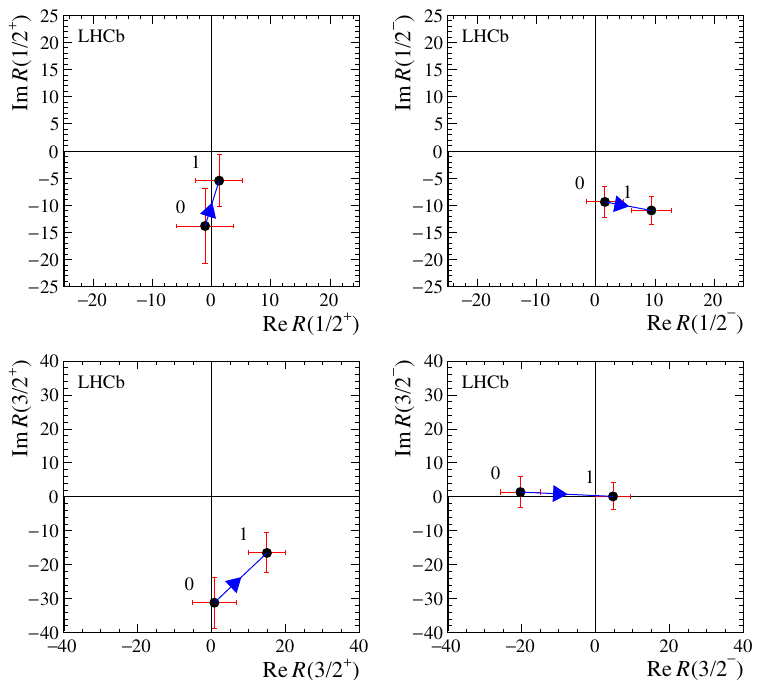
Figure 8 . Argand diagrams for the four amplitude components underneath the (cid:3) c (2880) + peak in the linear nonresonant model. In each diagram, point 0 corresponds to M ( D 0 p ) = 2 : 86 GeV, and point 1 to M ( D 0 p ) = 2 : 90